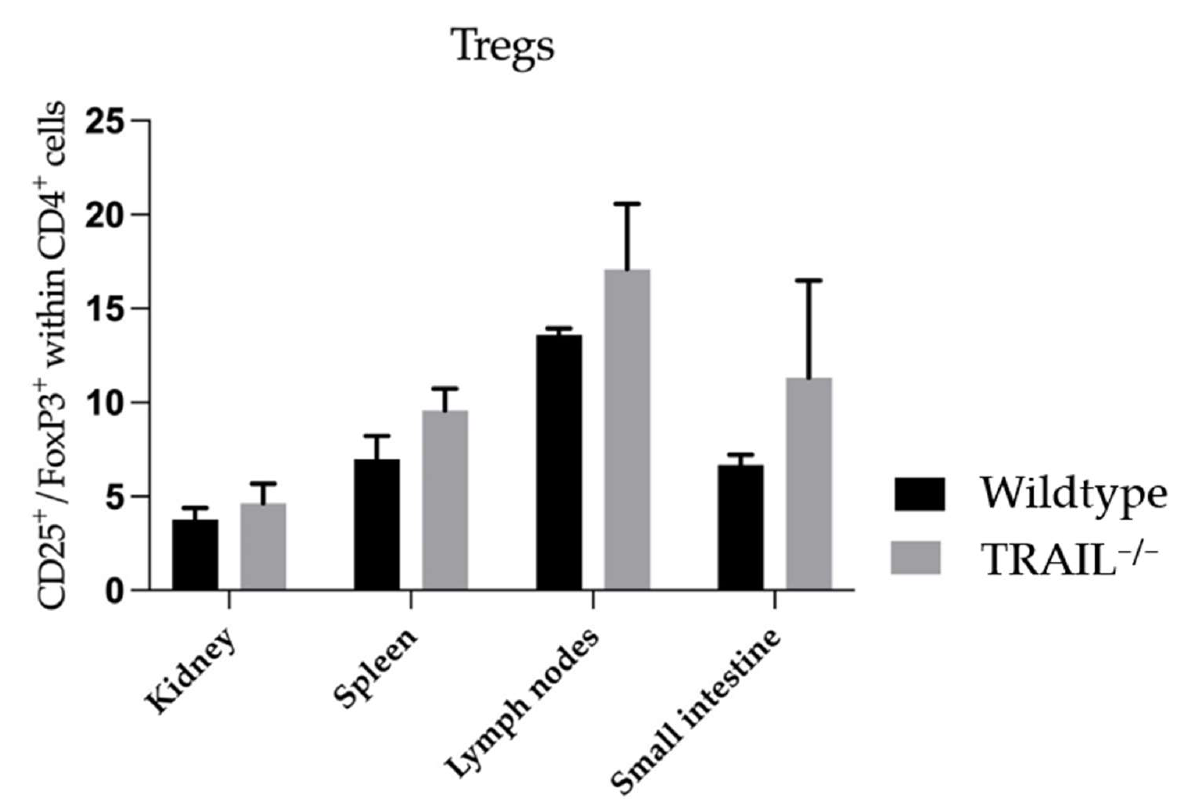
Figure 8. Histogram compares means ± SEM of Tregs in kidney, spleen, lymph nodes, and small intestines of TRAIL − / − mice versus wildtype C57BL/6 mice ( t -test, n = 6 per group).